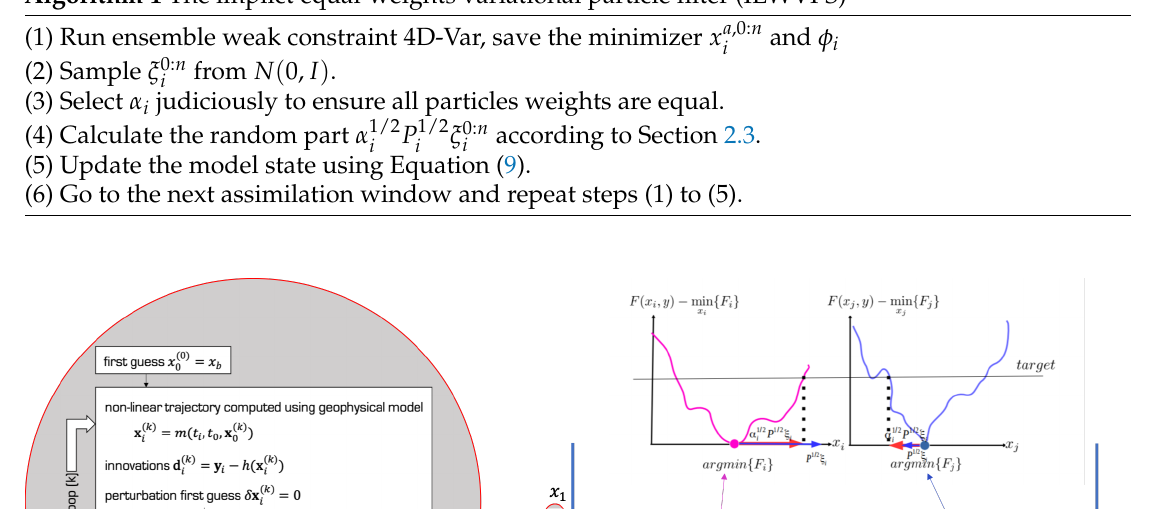
Figure 1. In the implementation of the IEWVPS, the weak contraint 4D-Var can be implemented in fully nonlinear or incremental form. Algorithm 1 The implict equal-weights variational particle filter (IEWVPS)